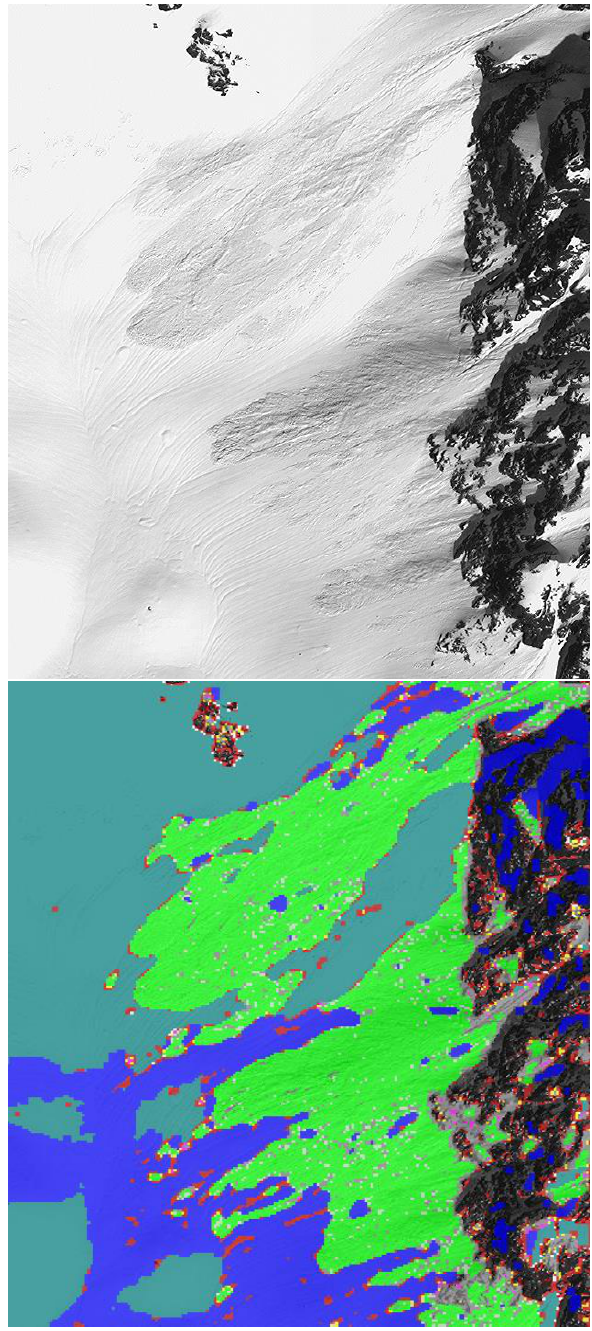
Figure 5: Classification result with the refined algorithm trained to differentiate the "rake" pattern from avalanche snow; the shown training section corresponds to the green rectangle in Figure 4. Top) raw image; bottom) automatic classification: green = avalanche debris; turquoise = glare and non-avalanche snow without rake pattern; blue = rake pattern; red = rock outcrops (Satellite image: Copyright ©